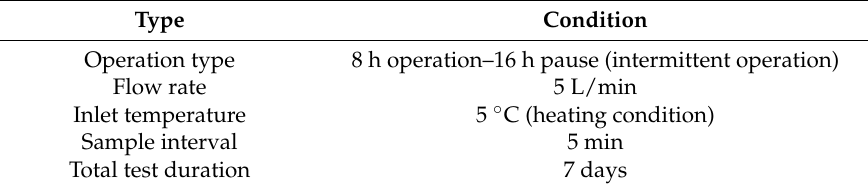
Table 6. Test conditions of in-situ thermal performance tests